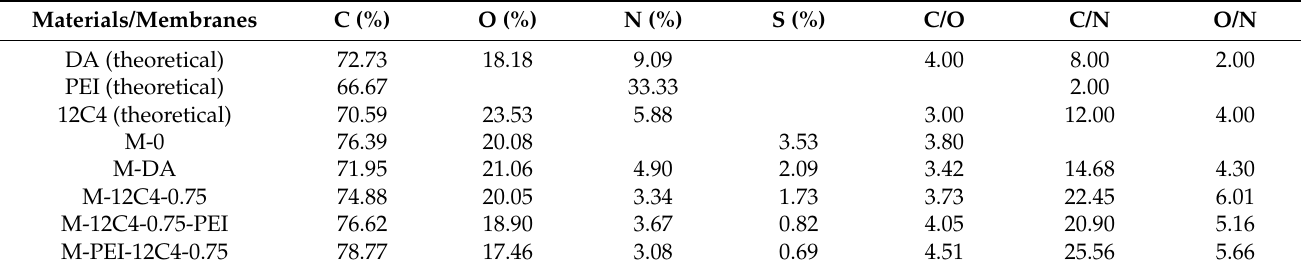
Table 1. Chemical composition of the pristine (M-0) and modified (M-DA, M-12C4-0.75, M-12C4-0.75-PEI, and M-PEI-12C4- 0.75) membranes surface from XPS